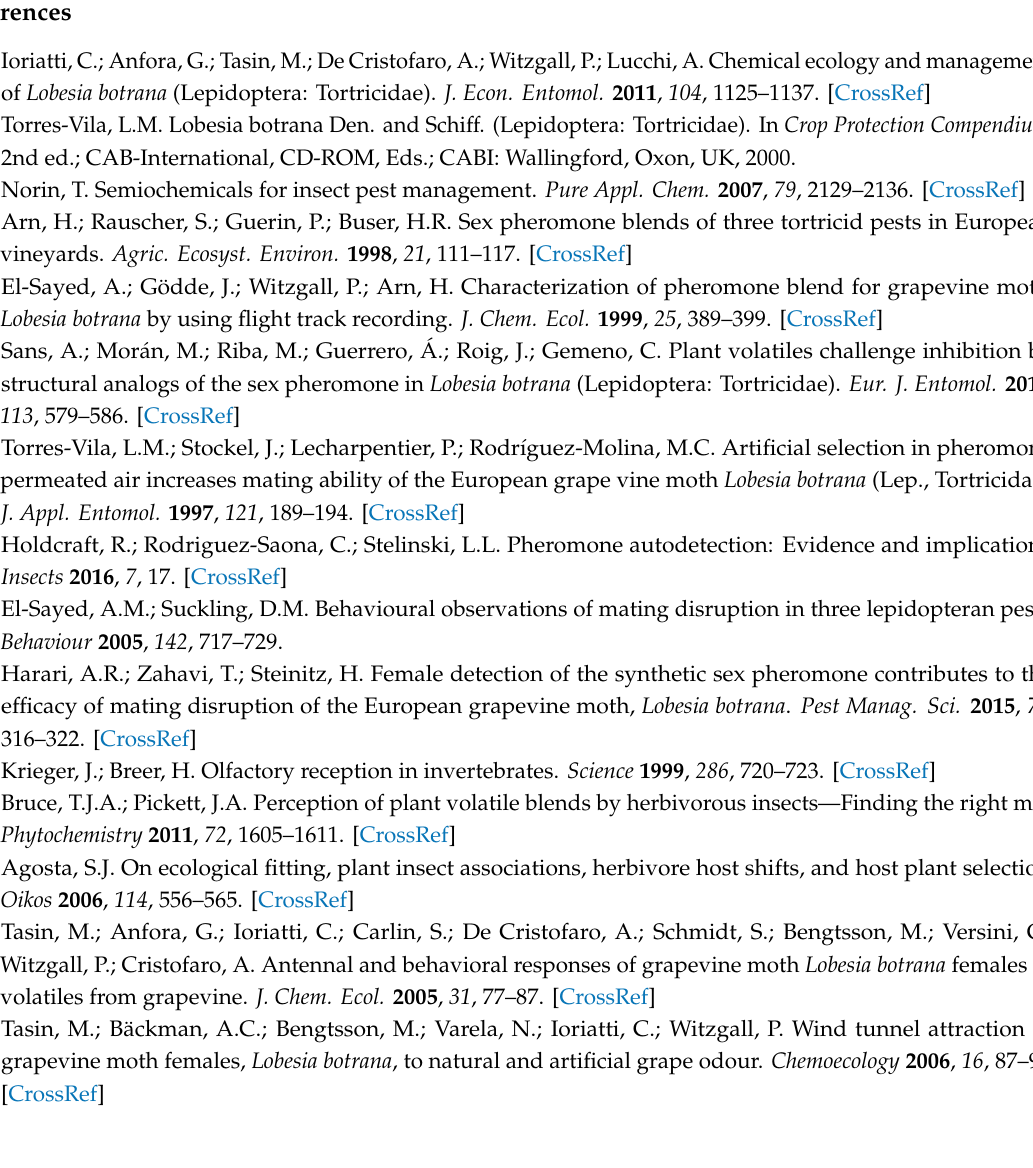
Table S1: Pairwise comparison tests (complete dataset), Table S2: Pairwise comparison tests (plant dataset), Table S3: Pairwise comparison tests (pheromone dataset), Figure S1: Representative EAG traces, Figure S2: mean EAG responses by sex and host plant